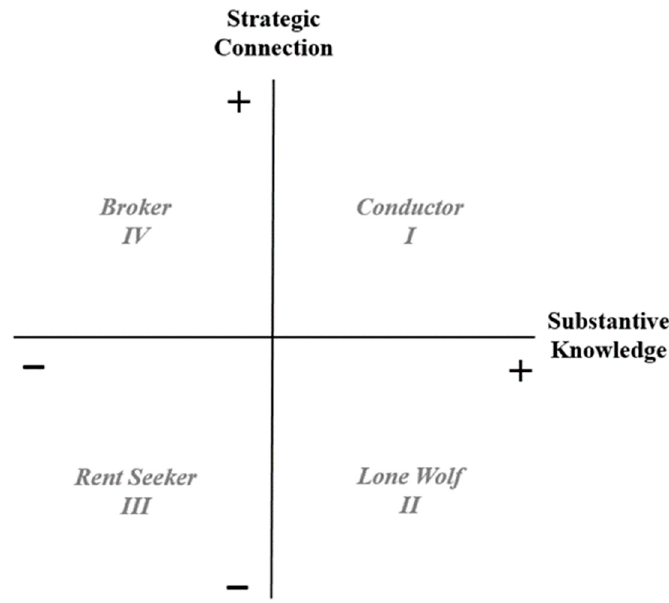
Figure 2. Strategic competence of actor.